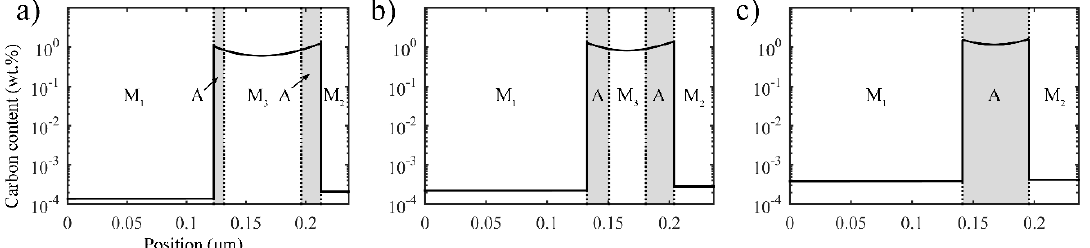
Figure 10. The final microstructure after the two-stage Q-P process corresponding to different second partitioning times. T Q1 = 325 °C, T P1 = 425 °C and the first partitioning time is 10 s, T Q2 = 250 °C, T P2 = 350 °C. In addition, the second partitioning time is: ( a ) 10 s; ( b ) 20 s and ( c ) 30